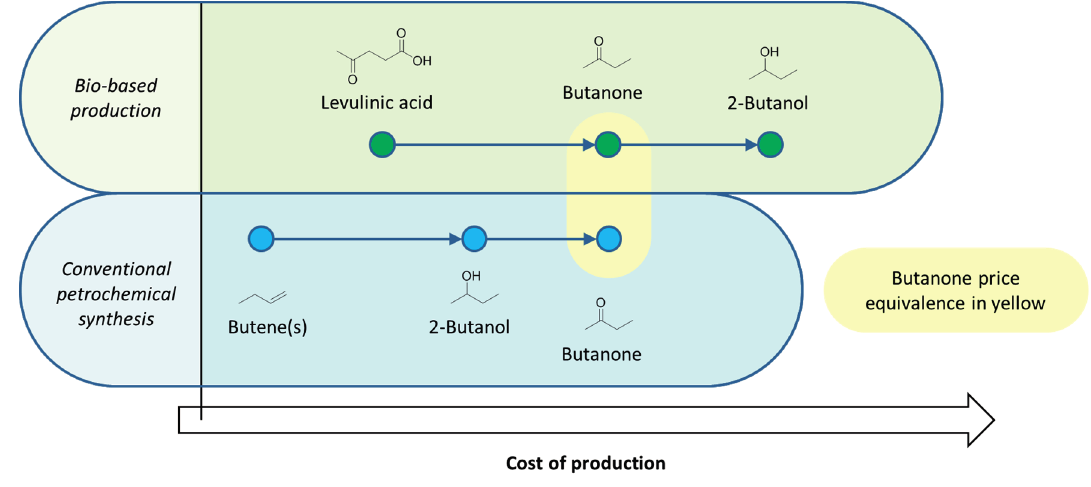
Figure 4. The effect of reversing the redox economy illustrated with 2-butanol. Relative costs of production have been estimated assuming a hypothetical scenario in which butanone prices are